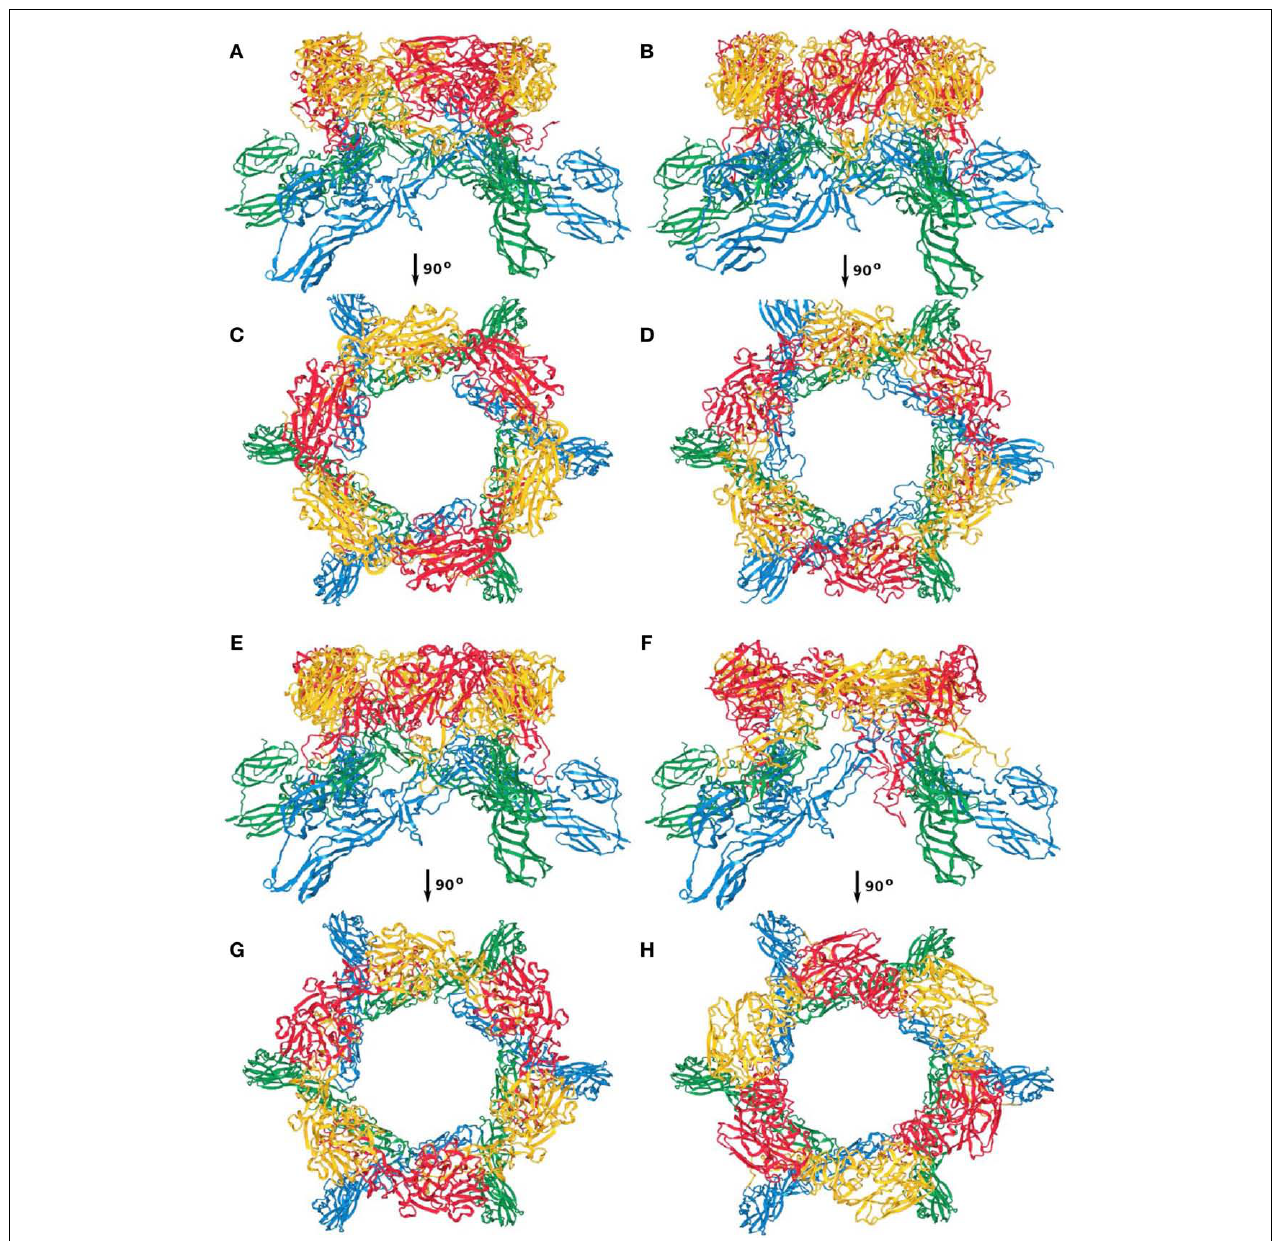
FIGUREA2 | Capsomer threefold axis; (A,C) first; (B,D) second; (E,G) third; (F,H) fourth top-scoring model.